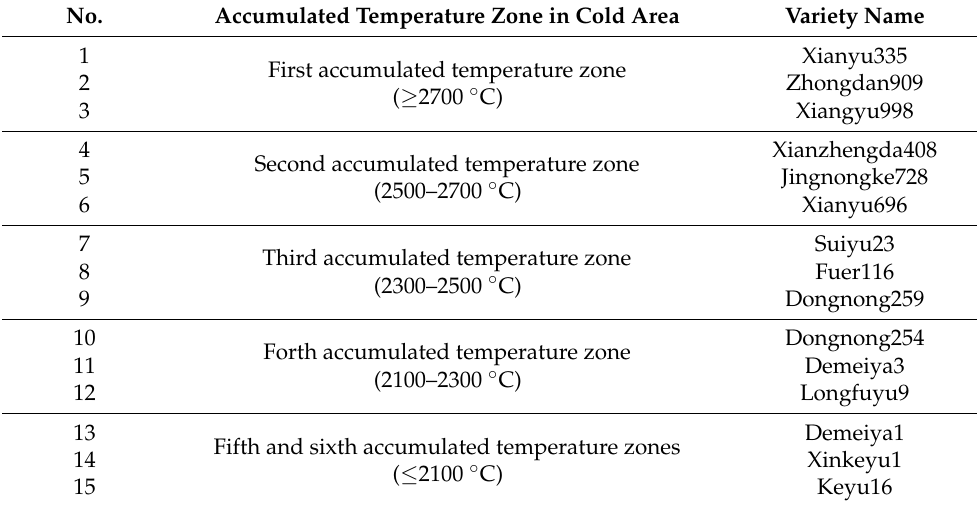
Table 1. Selection and number of maize varieties in a cold area of China.